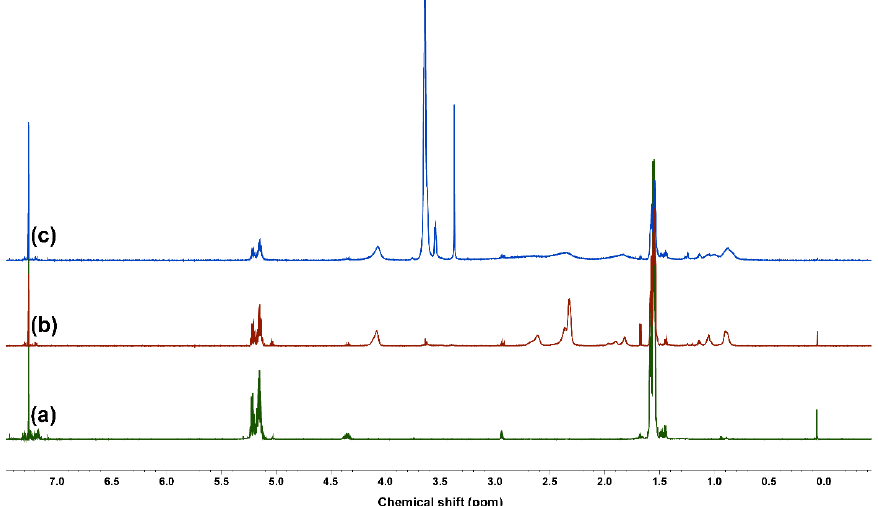
Figure 1. 1 H NMR (600 MHz) spectra in CDCl 3 of: ( a ) hydrophobic biodegradable poly(D,L-lactide) (PLA, DP n = 22); ( b ) amphiphilic PLA-b-PDMAEMA diblock copolymer ( DP n DMAEMA = 16, D2); ( c ) amphiphilic triblock copolymer with short oxyethylene side groups (PLA-b-PDMAEMA-b-POEGMA, DP n OEGMA = 12, T2-3).